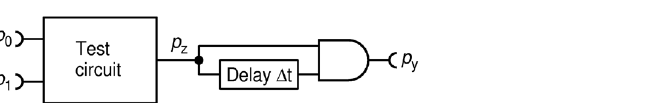
Figure 24. A circuit for testing an FPGA realization of a squaring circuit for a time-discrete RPT. The circuit multiplies the input RPT with its copy delayed by one period of the CLK